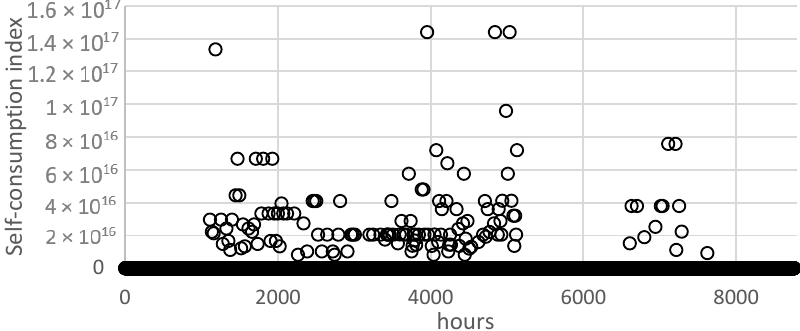
Figure 17. Self-consumption index for a single year.